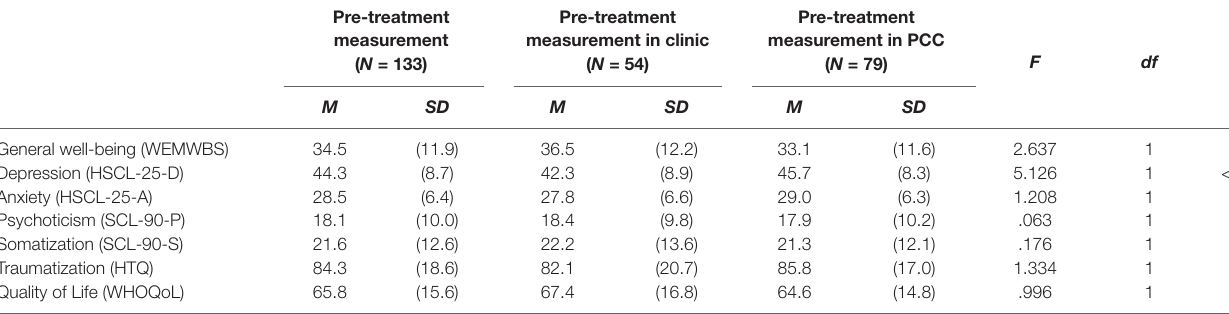
TABLE 4 | Mental health of refugees turning to psychiatric hospitals and PCC (MANOVA).